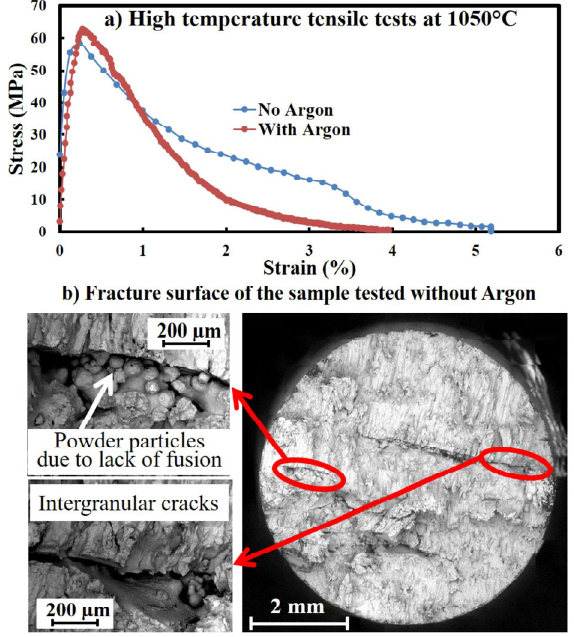
Figure 9. ( a ) The tensile property of the as ‐ built EBM IN625 samples at 1050 °C. ( b ) Fracture surface of the samples tested without shielding gas. Large lack of fusion defects and intergranular cracks can be observed in the inserts.